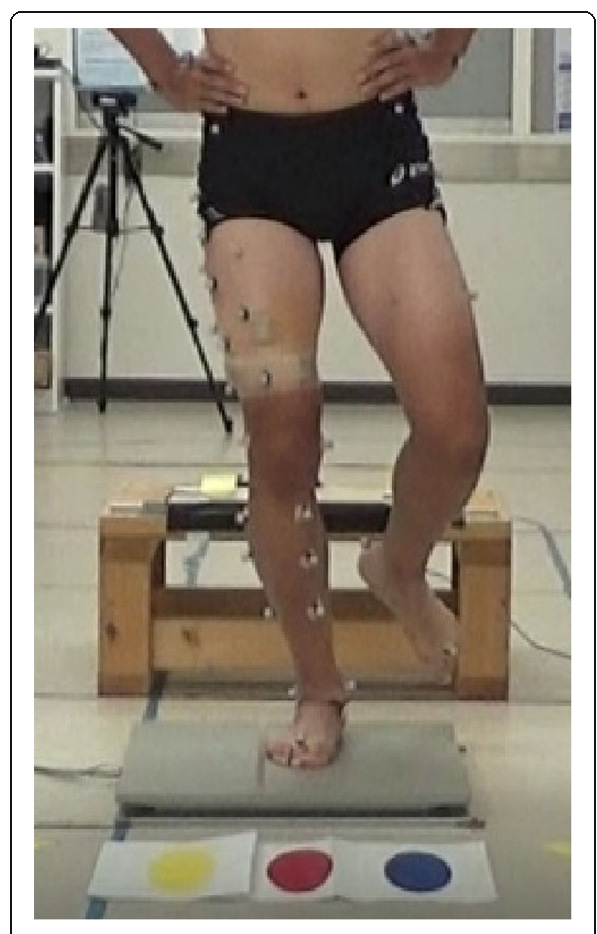
Fig. 1 The subject jumps from a 30-cm platform onto a footplate. The landing site is one of three colors displayed on a monitor in front of the